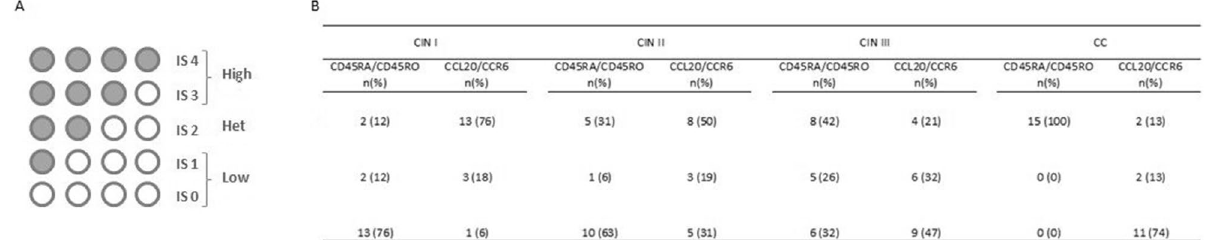
Figure 7. ( A ) ‘Immunoscore’ scheme classification. Using the median CD45RA + or CD45RO + cell density of all analyzed cervical lesions samples as cut-off value, samples were classified as high or low CD45RA + and high or low CD45RO + in IE and MS separately. Subsequently, samples were subdivided into five groups (0–IV) according to their CD45RA + and CD45RO + cell infiltration of IE and MS as described previously by